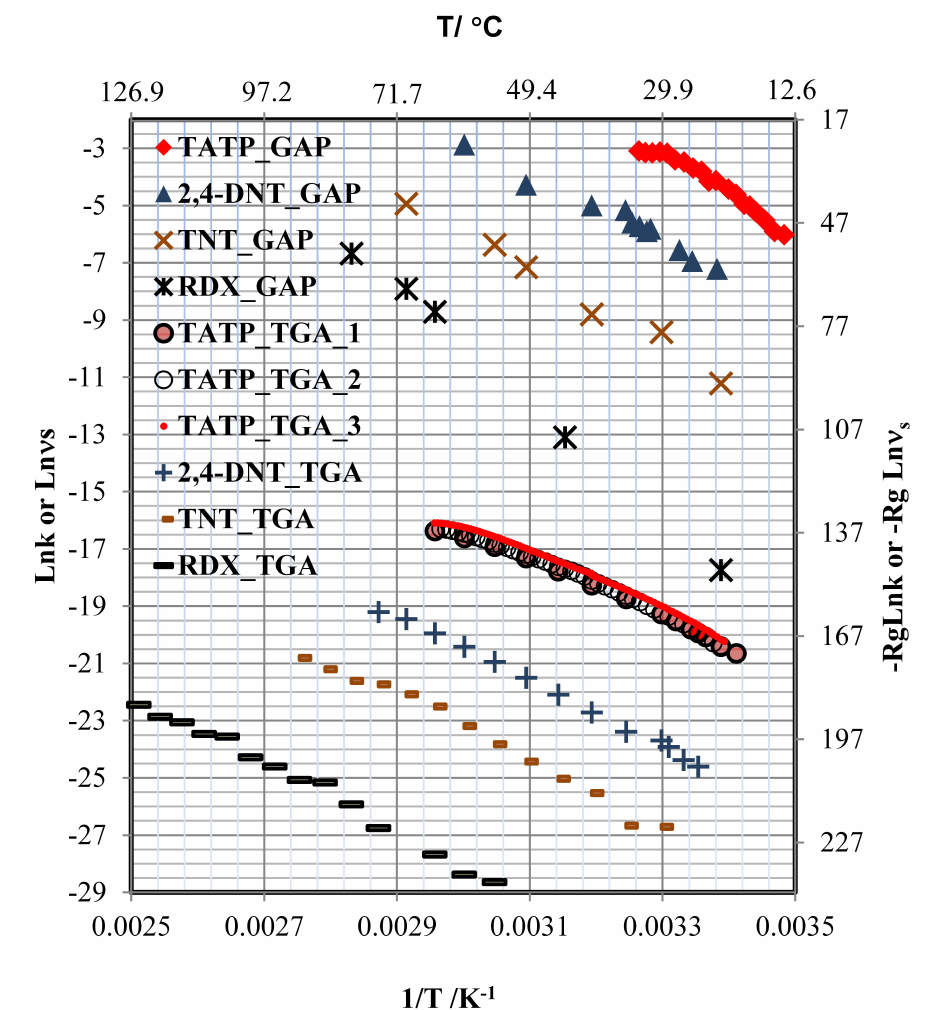
Figure 5. Arrhenius plots of GAP and TGA data used to obtain the sublimation rates for TATP, 2,4-DNT, TNT, and RDX. The units for GAP are s − 1 and for TGA are kg · s − 1 . The values obtained for ∆ C p by TGA and GAP are